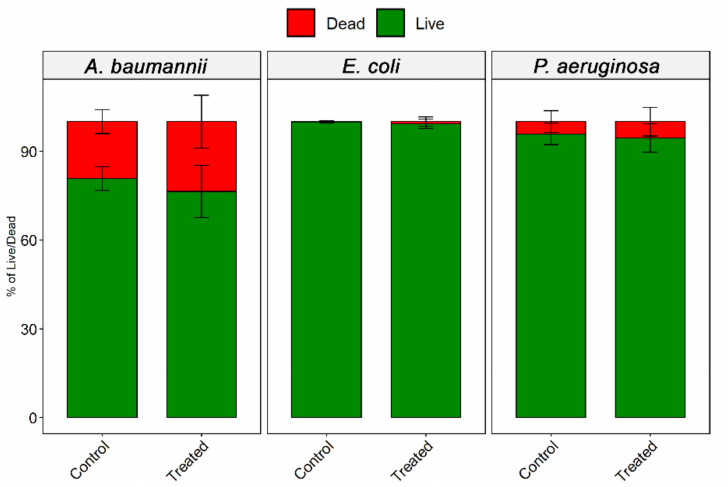
Figure 3. Quantification of live/dead bacteria after exposure to O 3 for 10 h. Percentage of live and dead cells quantified from different microscopic images.